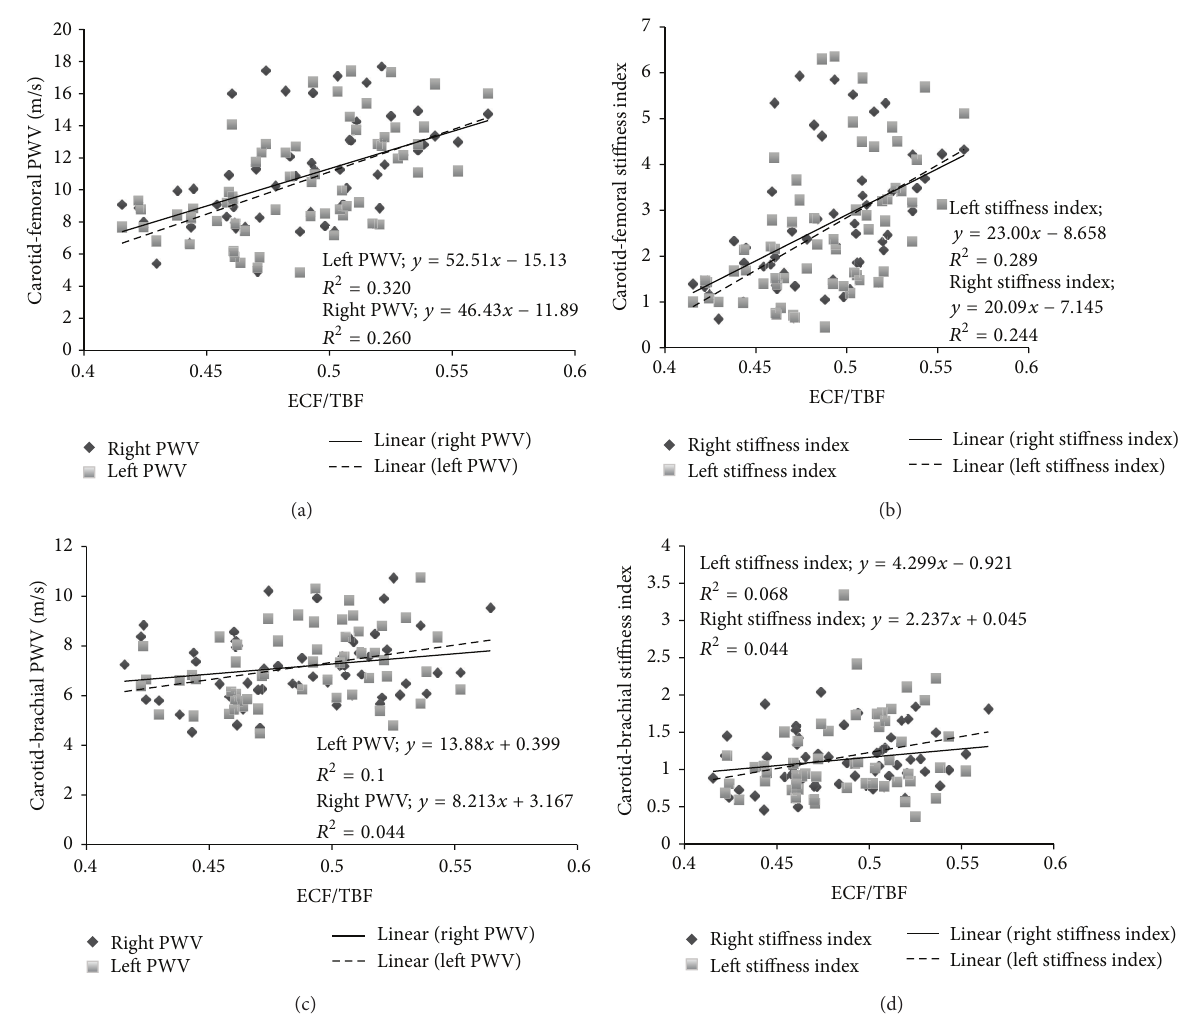
Figure 2: Pulse wave velocity (PWV) and hydration status evaluated through extracellular/Total Body Fluid ratio (ECF/TBF) measured using multi-impedancimetric technique. The carotid-femoral PWV-ECF/TBF relationship shows a significant relationship ( 𝑃 < 0.05 ), as the stiffness index ( 𝛽 )-ECF/TBF relationship ( 𝑃 < 0.05